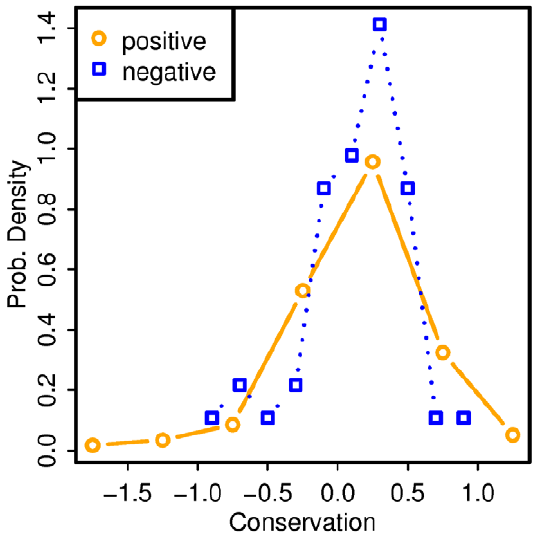
Figure 5. Distributions of conservation scores of peptides with positive and negative T-cell assay results for viruses in the context of immunization with peptides. The difference between the two distributions is not statistically significant (Welch’s t-test; one- sided; p-value=0.62).